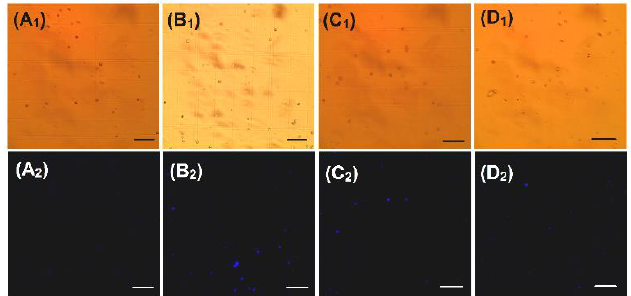
Fig. 4. Bright field – BF (upper panel) and fluorescent – FL (lower panel) microscopic images of the Chaetoceros sp. cells containing solution right after the diatoms being added (A), and after 1h (B), 2h (C), 4h (D) cultivation. The scale bars in the image are 5